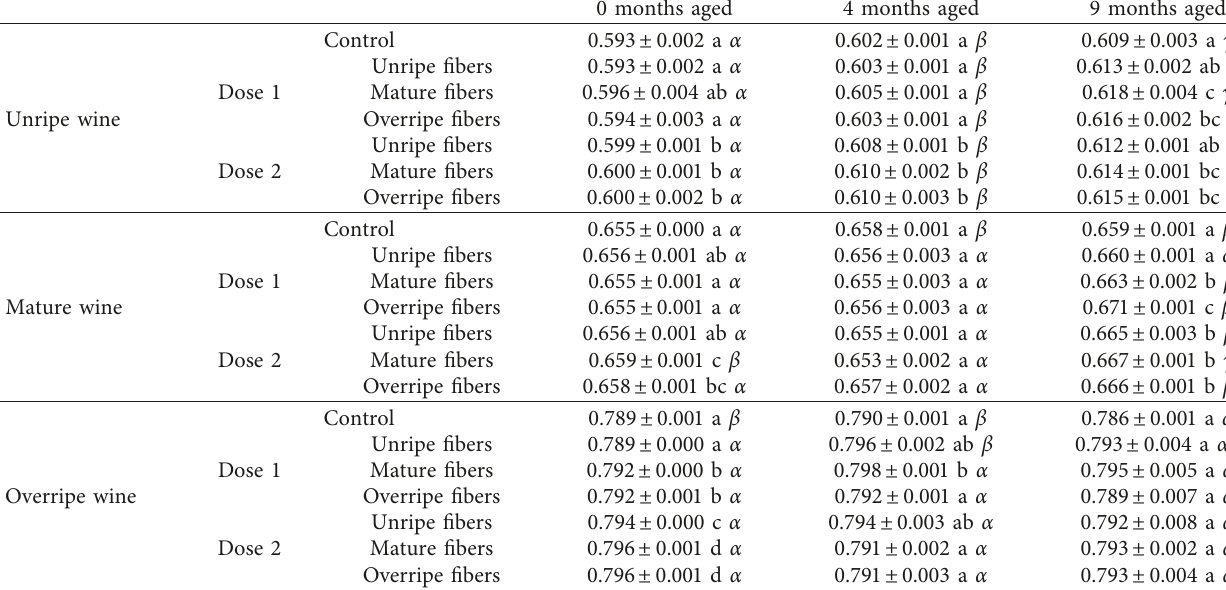
Table 5: Hue ( T ) of the wines.